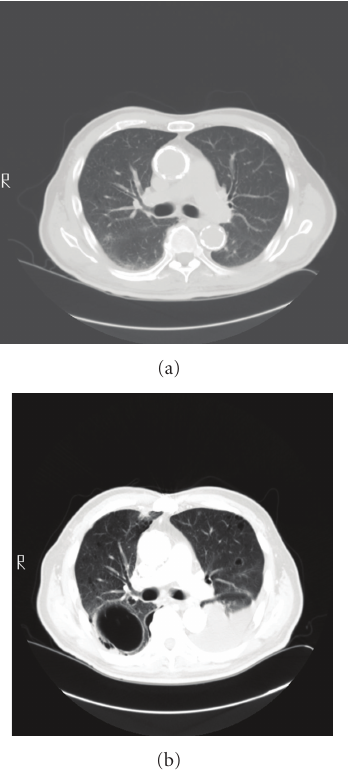
Figure 2: CT scans of the chest at 6-month interval showing a new left pleural e ff usion and a large thin-walled cystic lesion in the right lung.